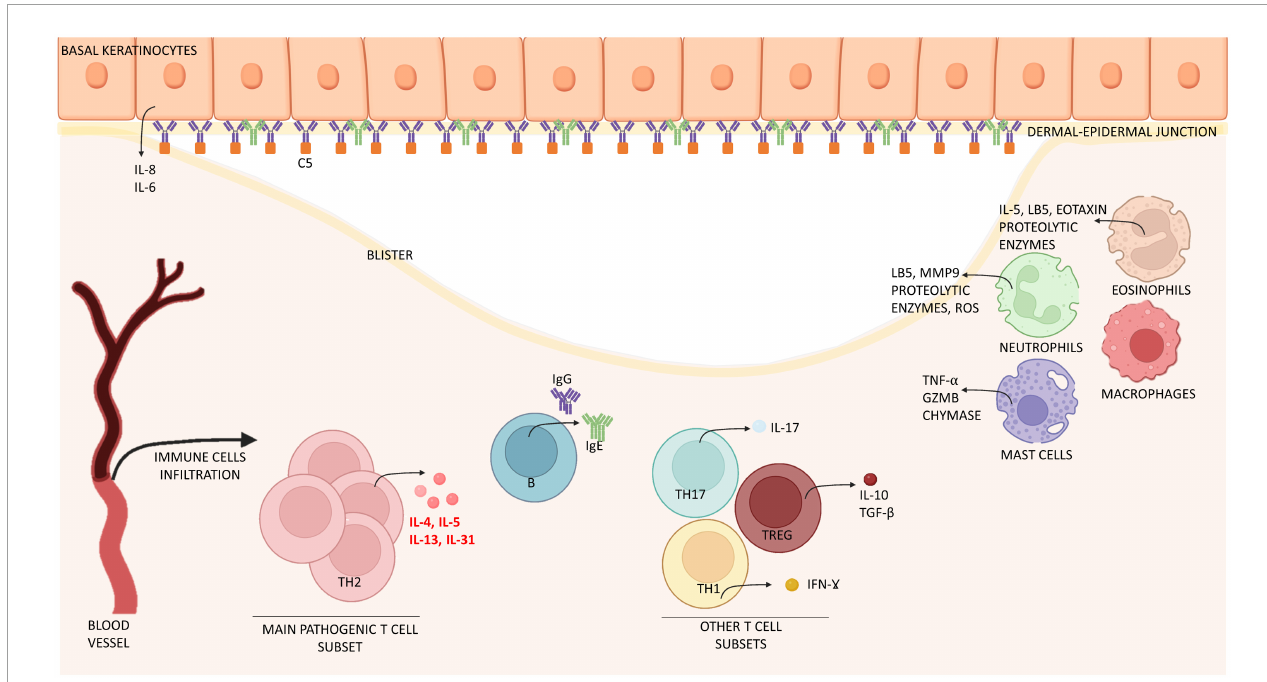
FIGURE1 Schematic representation of immune cells and molecules involved in the pathogenesis of bullous pemphigoid. Bullous pemphigoid is determined by IgG, IgE attaching BP180 located in the dermal-epidermal junction. Epidermal cells react by releasing interleukin (IL) 6 and 8. Eventually, this process leads to the recruitment of immune cells (mast cells, macrophages, and eosinophils) which infiltrate the skin and release inflammatory interleukins (IL) and proteolytic enzymes. T cells contribute to this inflammatory process by releasing interleukins at both peripheral (blood) and lesional (skin) level. Especially IL-4, IL-13, IL-31 are crucially involved in B cell proliferation, antibody production and Ig-class switching, itch and eosinophils activation, while IL-17 support neutrophil recruitment. Together, immune cells induce expression of chemokines, thus increasing skin infiltration. The result of this process is the formation of erythematous urticarial plaques and, later, dermal-epidermal splitting causative of blistering. IL, interleukin; Ig, immunoglobulin; Th, T helper; TGF- β , tumor growth factor β ; IFN- G , interferon G ; GZMB, granzyme B; MMP9, matrix-metallopeptidase 9; LB5, leukotriene B 5; ROS, reactive oxygen species; C5, complement component